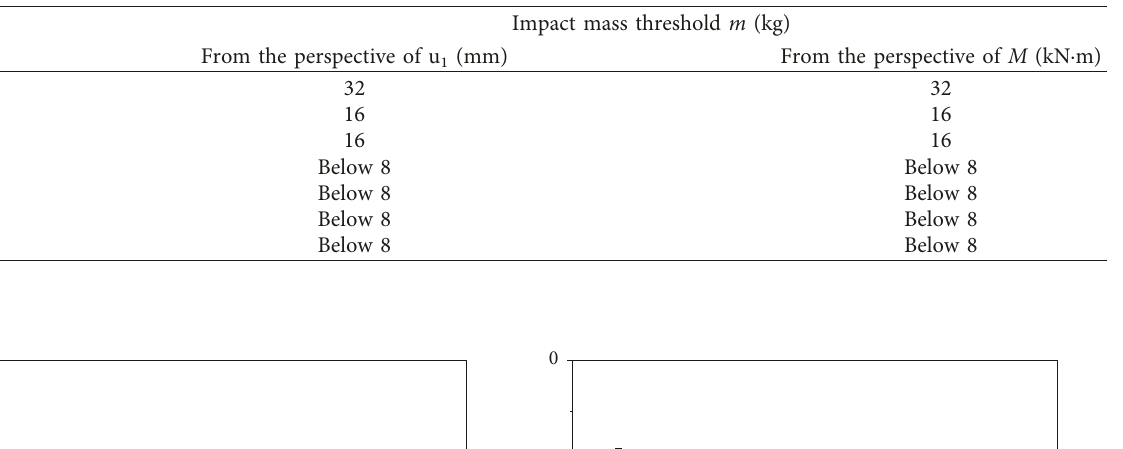
Table 3: Impact mass threshold m .